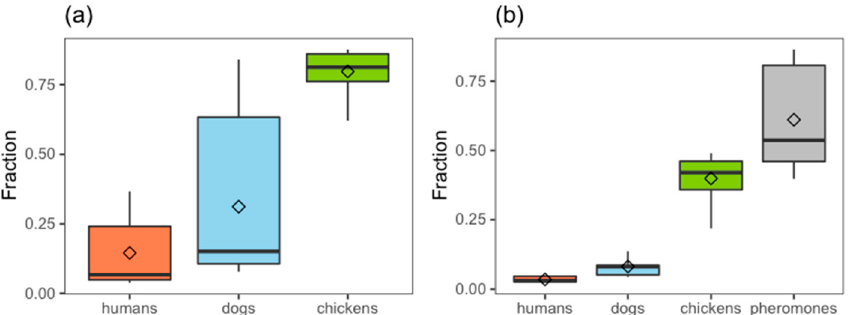
Figure 3. Lu. longipalpis estimated preference for hosts and pheromones: ( a ) in the absence of the synthetic pheromone; ( b ) in the presence of the synthetic pheromone.